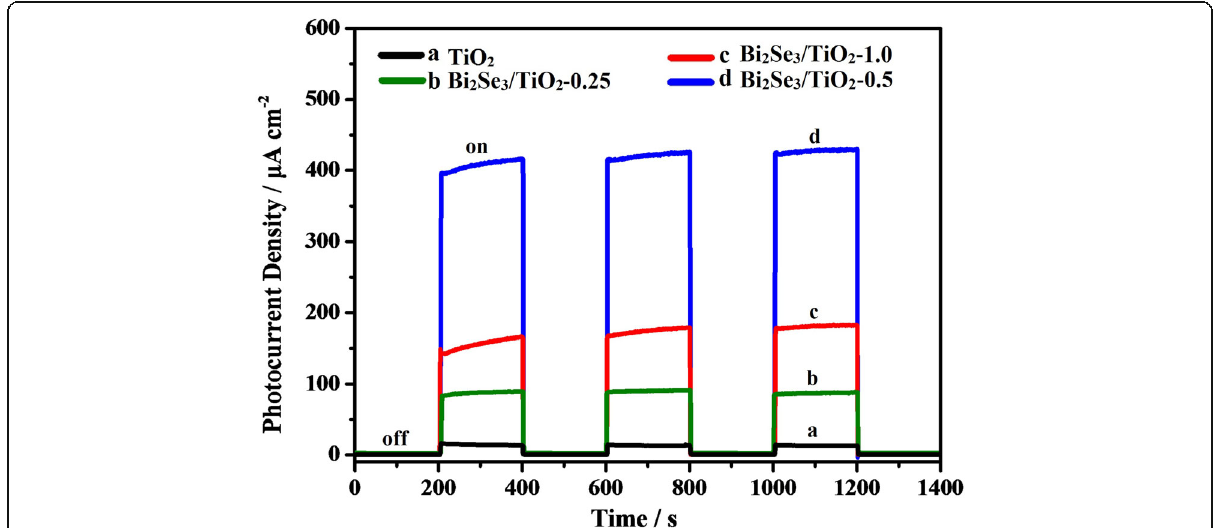
Fig. 6 Photocurrent density vs. time curves for pure TiO 2 and Bi 2 Se 3 /TiO 2 nanocomposites in 0.1 mol/L Na 2 S and 0.2 mol/L NaOH mixed solution